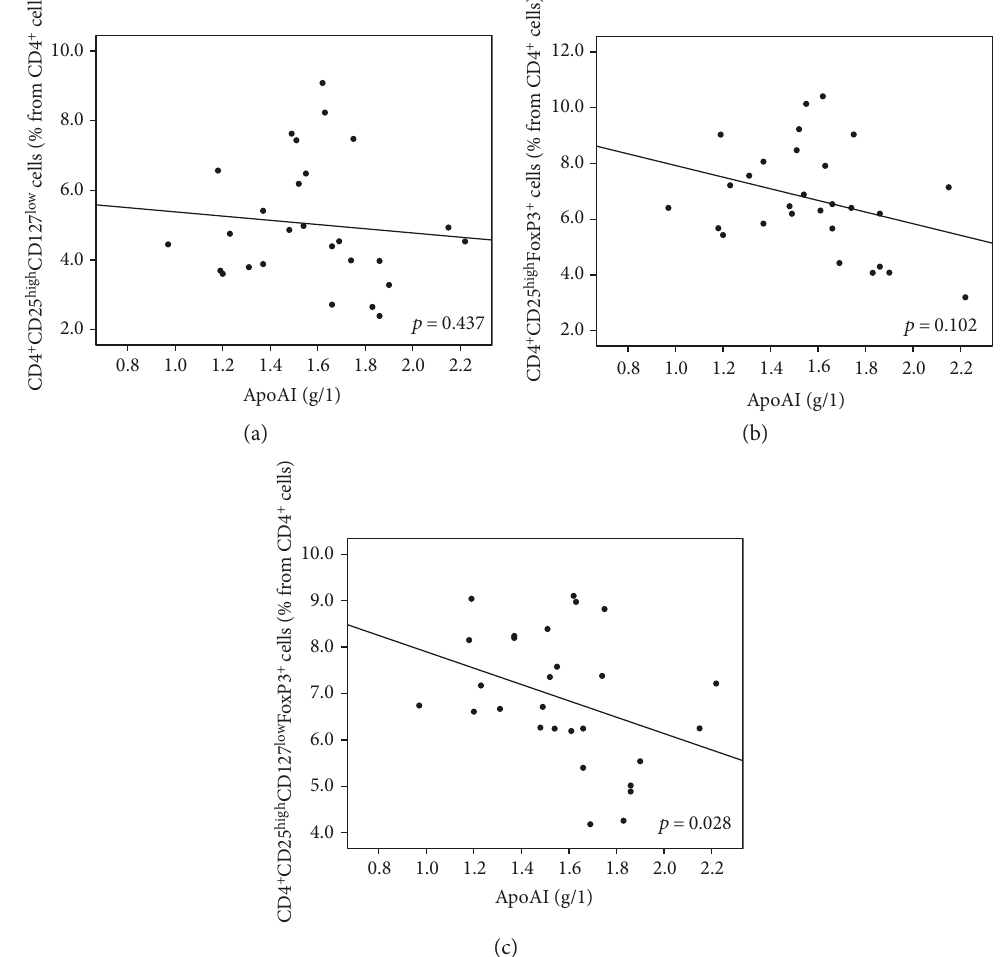
Figure 7: (a – c) The relationship between T regulatory cells and ApoAI. Higher level of ApoAI correlated with lower Treg numbers. This correlation was signi fi cant in the case of CD127 low FoxP3 + cells ( p = 0 028 , R = − 0 416 ). The same trend was observed for both FoxP3 + and CD127 low Treg cells but failed to reach signi fi cant levels ( p = 0 102 , R = − 0 315 and p = 0 437 , R = − 0 156 , resp.). (a) CD127 low Treg cells (% from CD4 + cells). (b) FoxP3 + Treg cells (% from CD4 + cells). (c) CD127 low FoxP3 + Treg cells (% from CD4 +